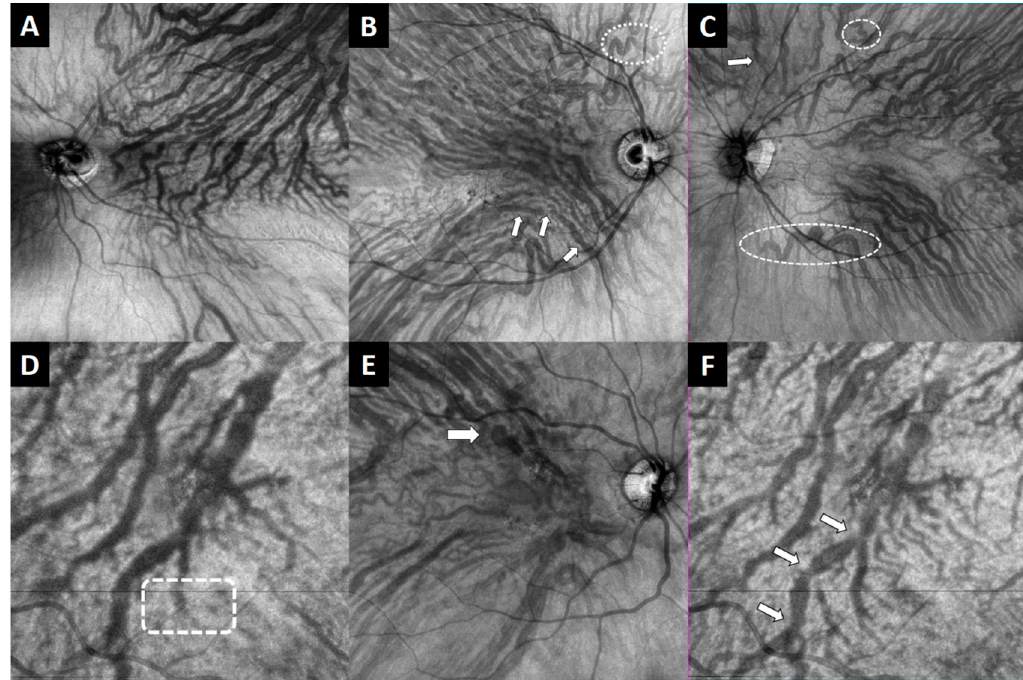
Figure 3. Examples of en face optical coherence tomography images of the choroidal vessel characteristics assessed. ( A ) Asymmetry with predominance of the superotemporal vessels. ( B ) Sausaging of the choroidal vessels (arrow) and corkscrew vessel (dotted circle). ( C ) Corkscrew vessels (dotted circles) and bulbosity (arrow). ( D ) Abrupt termination of a choroidal vessel. ( E ) Bulbosity of a choroidal vessel (arrow). ( F ) Sausaging of a choroidal vessel (arrows).